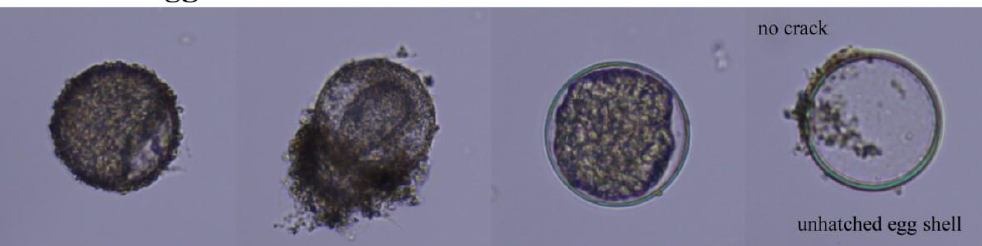
Figure 2. Normal and abnormal copepod eggs from the sediment of Masan Bay in August 2011 and April 2012.